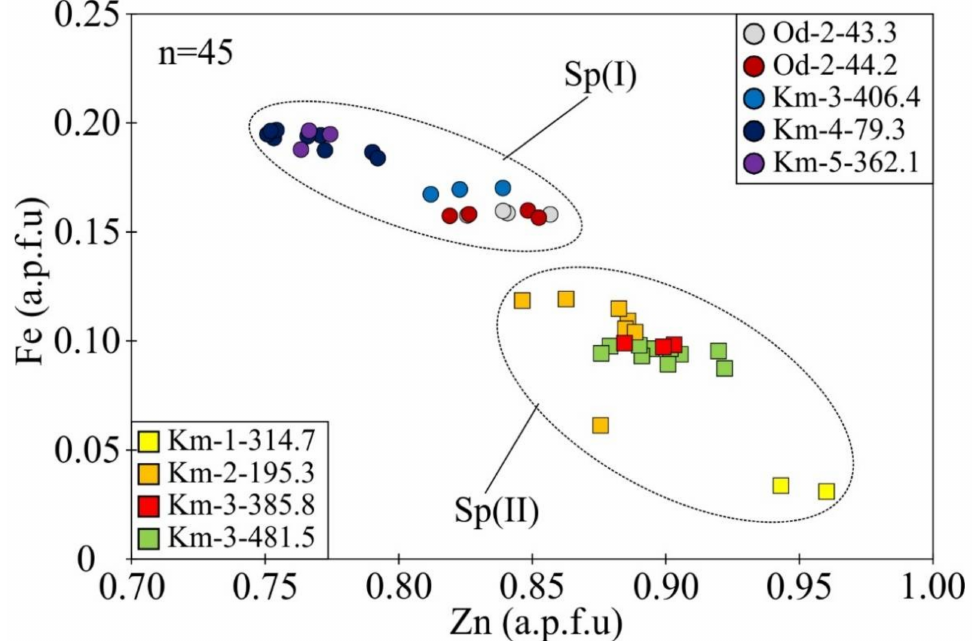
Figure 13. Variations in composition of sphalerite (Fe and Zn apfu) from samples studied. Fahlore, similar to galena, was one of the most widespread sulfide minerals of later stages, and sometimes it played a dominant part in the quantitative aspect. Though fahlore investigation. Fahlore formed allotriomorphic aggregates and occured as micro-veinlets tion or thin micro-veinlets in skarn and in silicified magmatic rocks of the Shakhtama complex. It was frequently associated with chalcopyrite (I-II), galena, sphalerite (II)